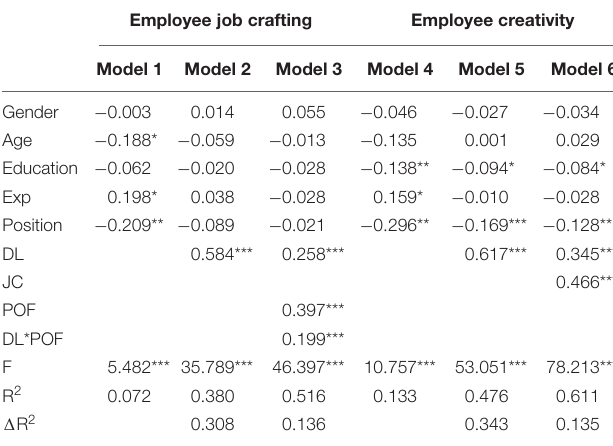
TABLE 3 | Results of hierarchical regression. Employee job crafting